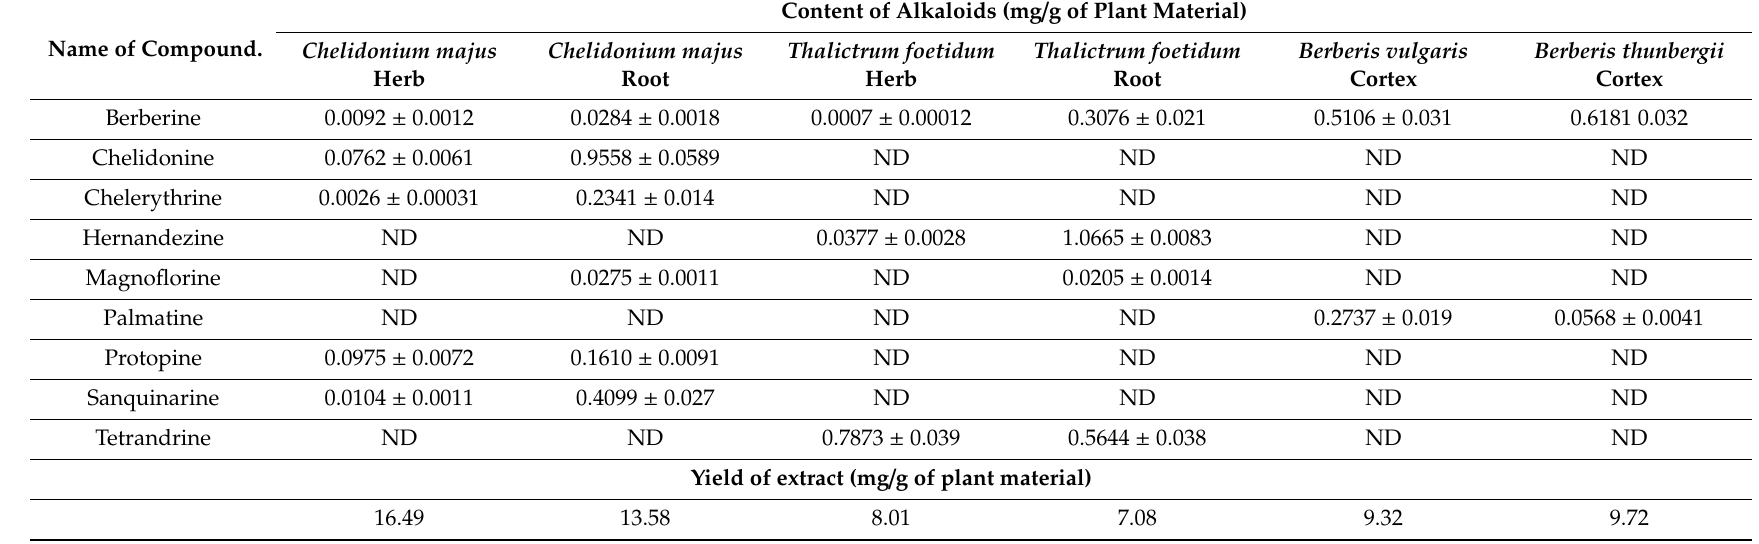
Table 3. Contents of alkaloids in plant samples and yield of extracts.